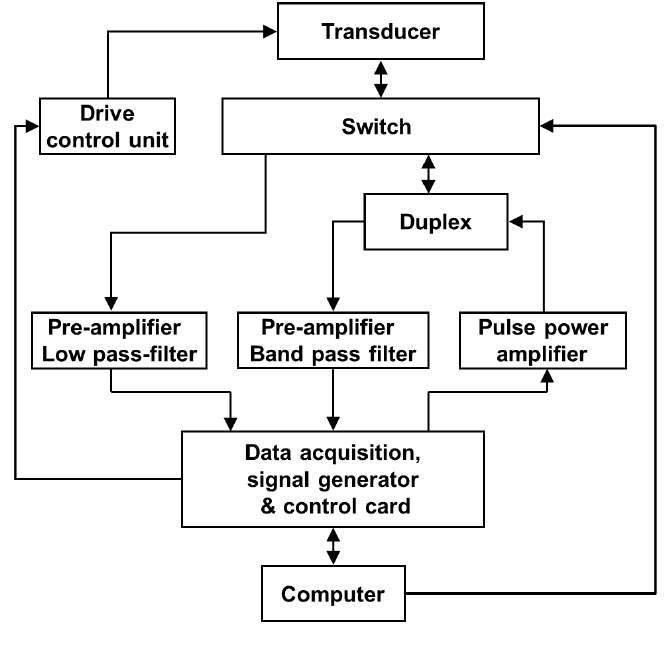
Figure 11. Schematic diagram of the corresponding inspection system for